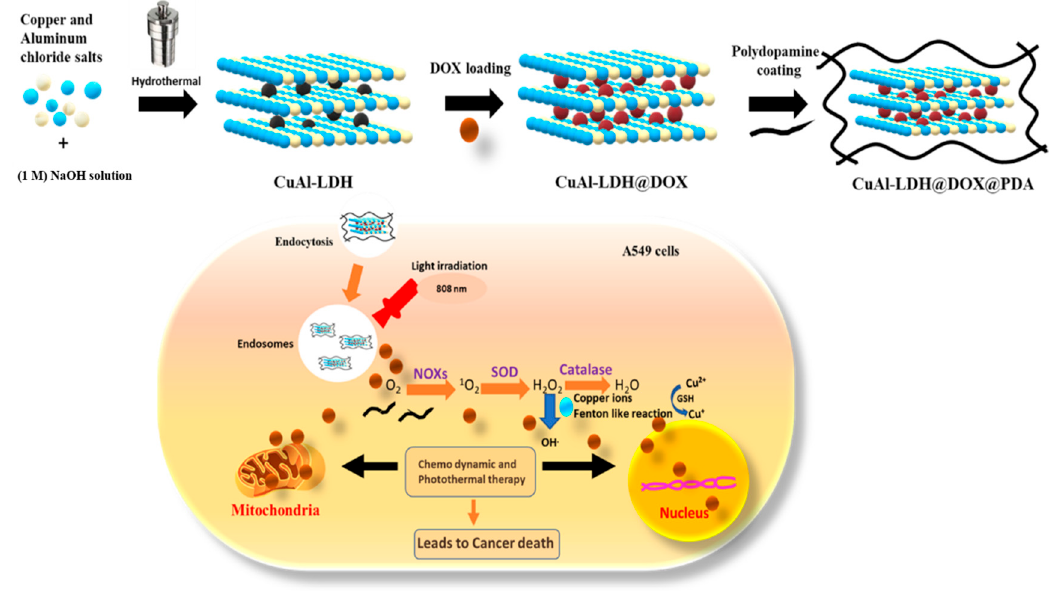
Scheme 1. Graphical representation of the synthesis of CuAl-LDH, DOX loading, and PDA coating. Cellular uptake mechanism, DOX releasing mechanism, and tumor cell eradication by chemo dynamic and photothermal therapy.